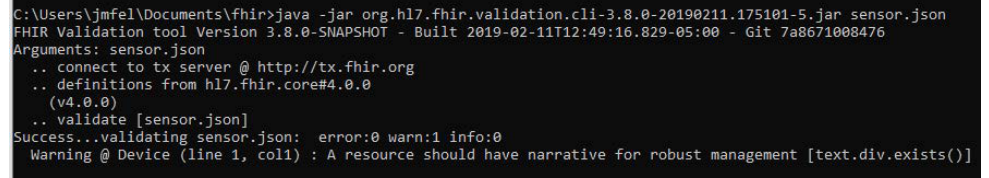
Figure 6. The FHIR validator consists of a “.jar” file which validates the resources that are in JSON format.